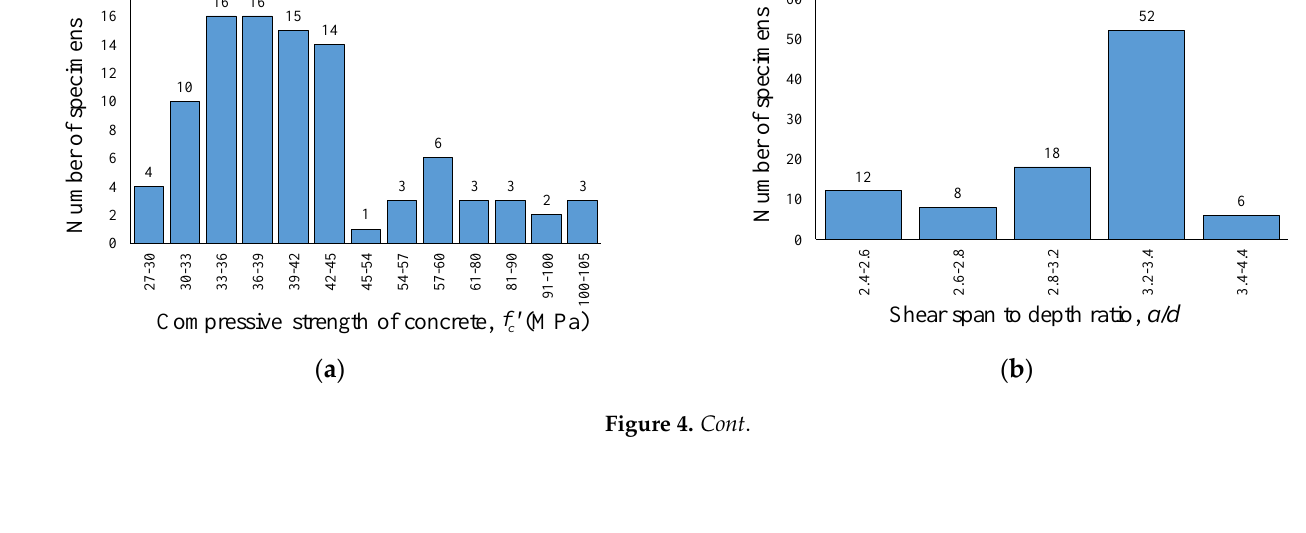
( d ) Figure 4. Distribution of key parameters in RCA with shear reinforcement. ( a ) Compressive strength of concrete, MPa. ( b ) Shear span-to-depth ratio. ( c ) Longitudinal reinforcement ratio. ( d ) Effective depth. 3. Comparability Study of RCA and NCA Beams To investigate the implication of recycled coarse aggregates on the shear capacity of reinforced concrete beams, the shear strength ratio between the RCA specimen and its control specimen (